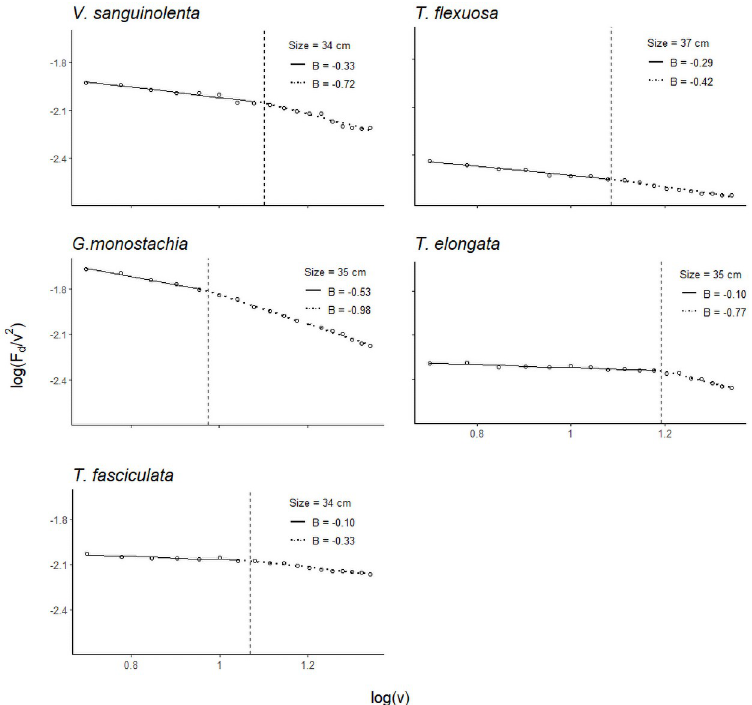
Fig 6. Change in Vogel exponent in a similar sized individual of each species. Dashed vertical lines indicate the breakpoint where the slope of the regression line changes abruptly. This means that at higher wind velocity, drag force is increasing more linearly with wind speed, according to F d � v 2+B , deviating from the quadratic relationship. Species differ in growth form and flexibility for reconfiguration to reduce drag force, as reflected by the Vogel exponent. Wind speed varied from 5–22 m s. 1 . Regressions for other plant sizes are provided in the [S3 Fig in S1 File ] .